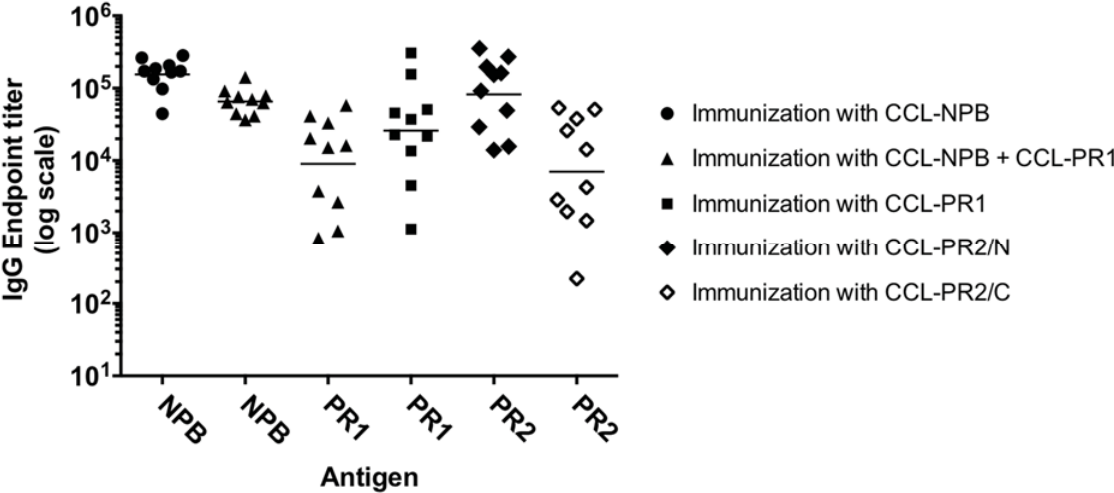
Figure 3. Anti-peptide IgG response in NMRI mice. Female NMRI mice (6–8 weeks of age) were immunized twice with SVLP constructs: CCL-NPB, CCL-PR1, CCL-NPB + CCL-PR1 (mixture), CCL-PR2/N or CCL-PR2/C (see Figure 1B). ELISA endpoint IgG titers measured against the target peptide (Antigen) for individual animals (symbol) and the geometric mean (black line) after the second immunization are shown. Preimmune sera showed no